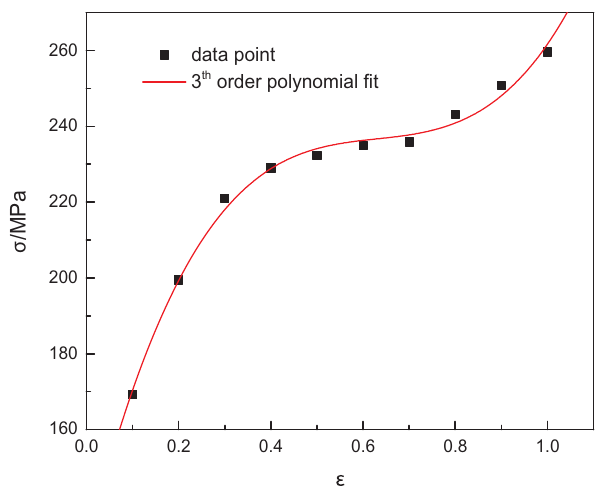
Figure 7: Relationship between σ and ε at 933 K and 1 s − 1 .